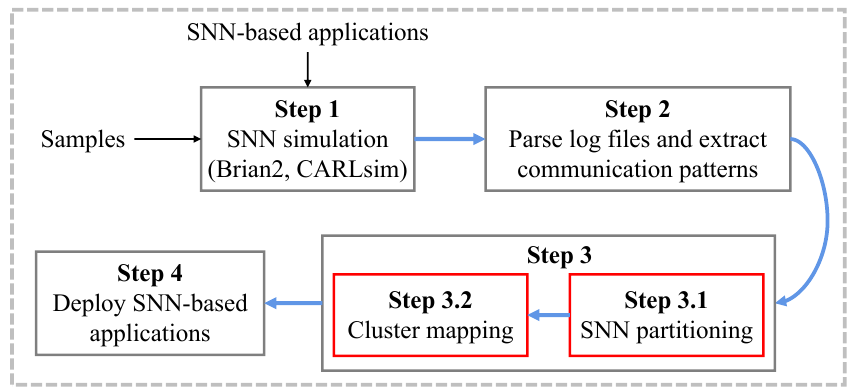
Figure 1. High-level overview of SpiNeMap [19] and SNEAP